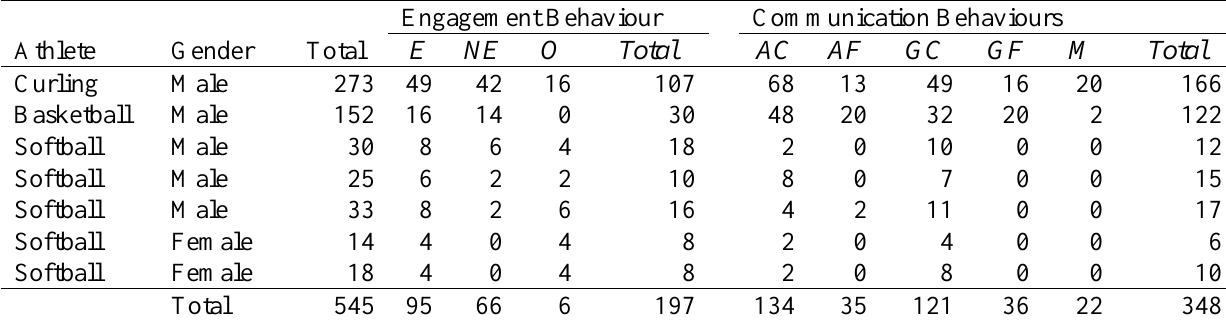
Table 2. Frequency of behaviours by athlete Engagement Behaviour Communication Behaviours